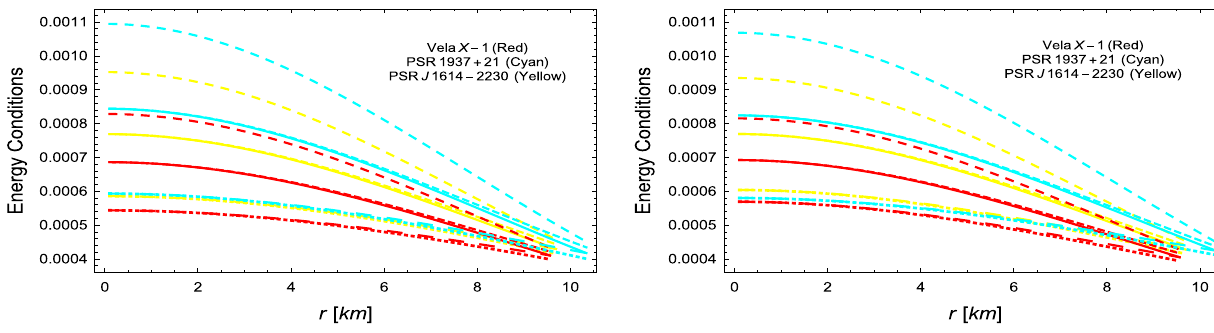
Fig. 6 Shows the variations of energy conditions (left panel for 1st solution and right panel for 2nd solution) with respect to